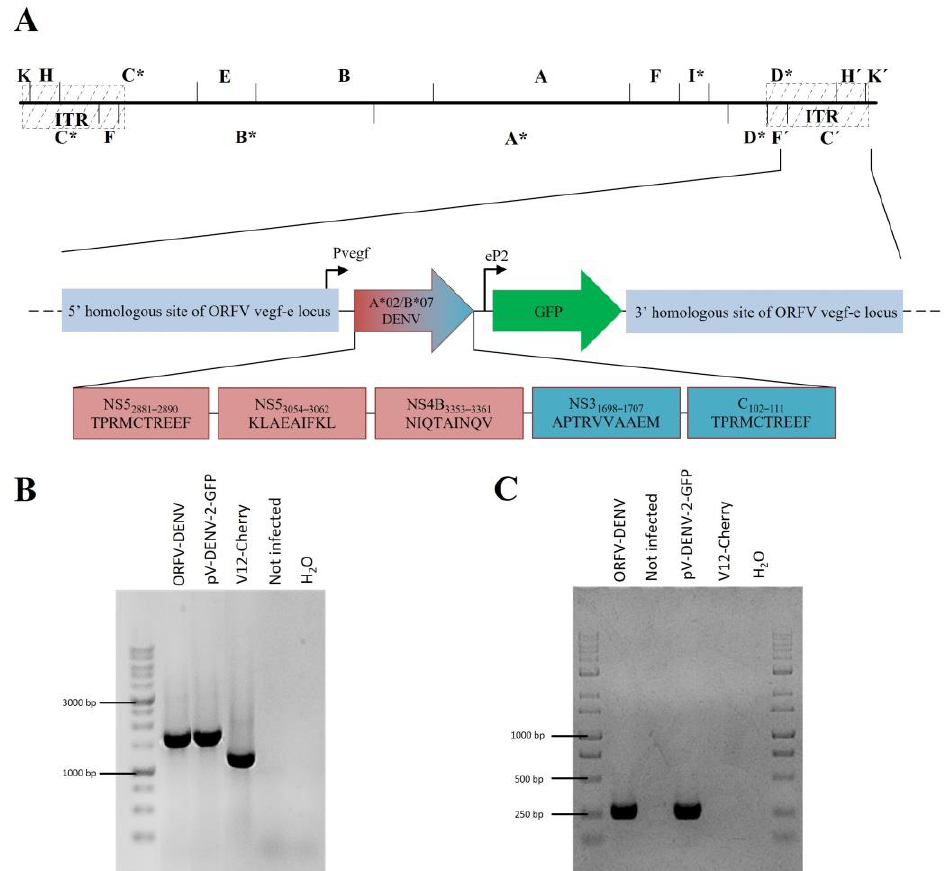
Figure 2. ( A ) Genomic map of ORFV-DENV depicting the arrangement of the minigenes encoding HLA-A*02- (red boxes) and HLA-B*07- (blue boxes) restricted DENV-derived epitopes controlled by the authentic early promoter Pvegf. The GFP gene used as a selection marker for virus purification is expressed under the control of the synthetic eP2 promoter. The 5′ and 3′ sequences homologous to the vegf-e locus of ORFV flanked the minigenes and the GFP sequence, enabling direct homologous recombination with the virus backbone. * DNA fragments affected by the genomic deletions ( B ) The genetic homogeneity of novel recombinants was verified by PCR targeting the vegf-e locus and resulted in the predicted amplicon size for ORFV-DENV (1640 bp). ( C ) DENV-specific PCR revealed the predicted amplicon sizes for ORFV-DENV (277 bp). Transfer plasmid pV-DENV-2-GFP was used as the positive control. DNA isolated from the parental ORFV V12-Cherry and non-infected cells served as the negative control.